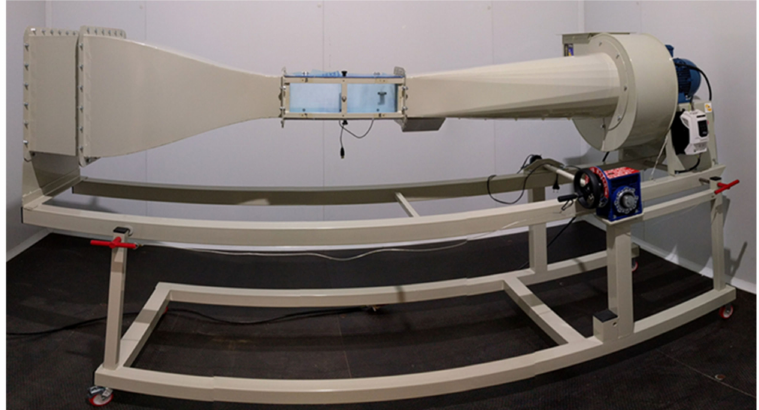
Figure 4. Icing wind tunnel.